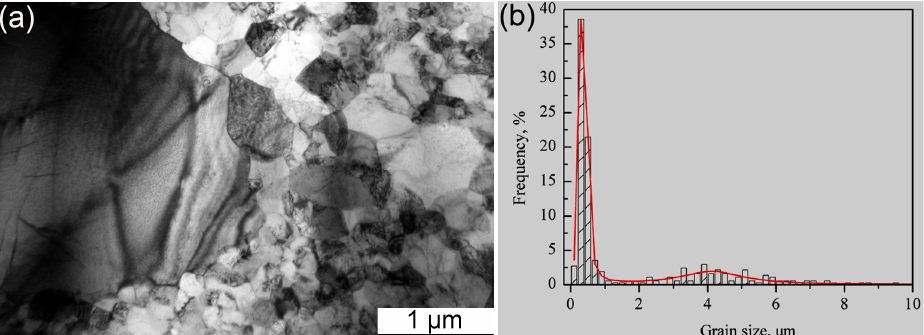
Figure 10. ( a ) TEM microstructure and ( b ) grain size distribution of the ODS steel.